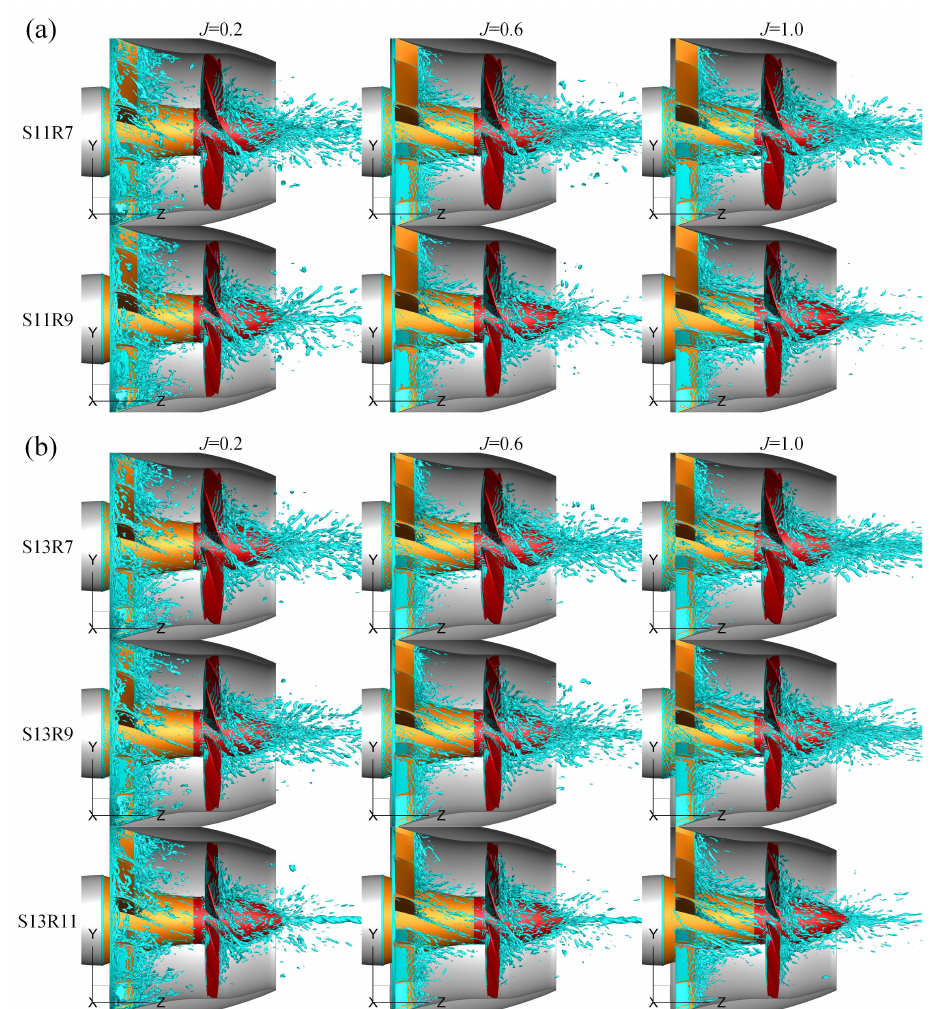
Figure 26. Interaction between the blade wake vortices of the rotor and stator of PJP models withholding the stator blade numbers: ( a ) different rotor blade numbers under 11 stator blades, ( b ) different rotor blade numbers under 13 stator